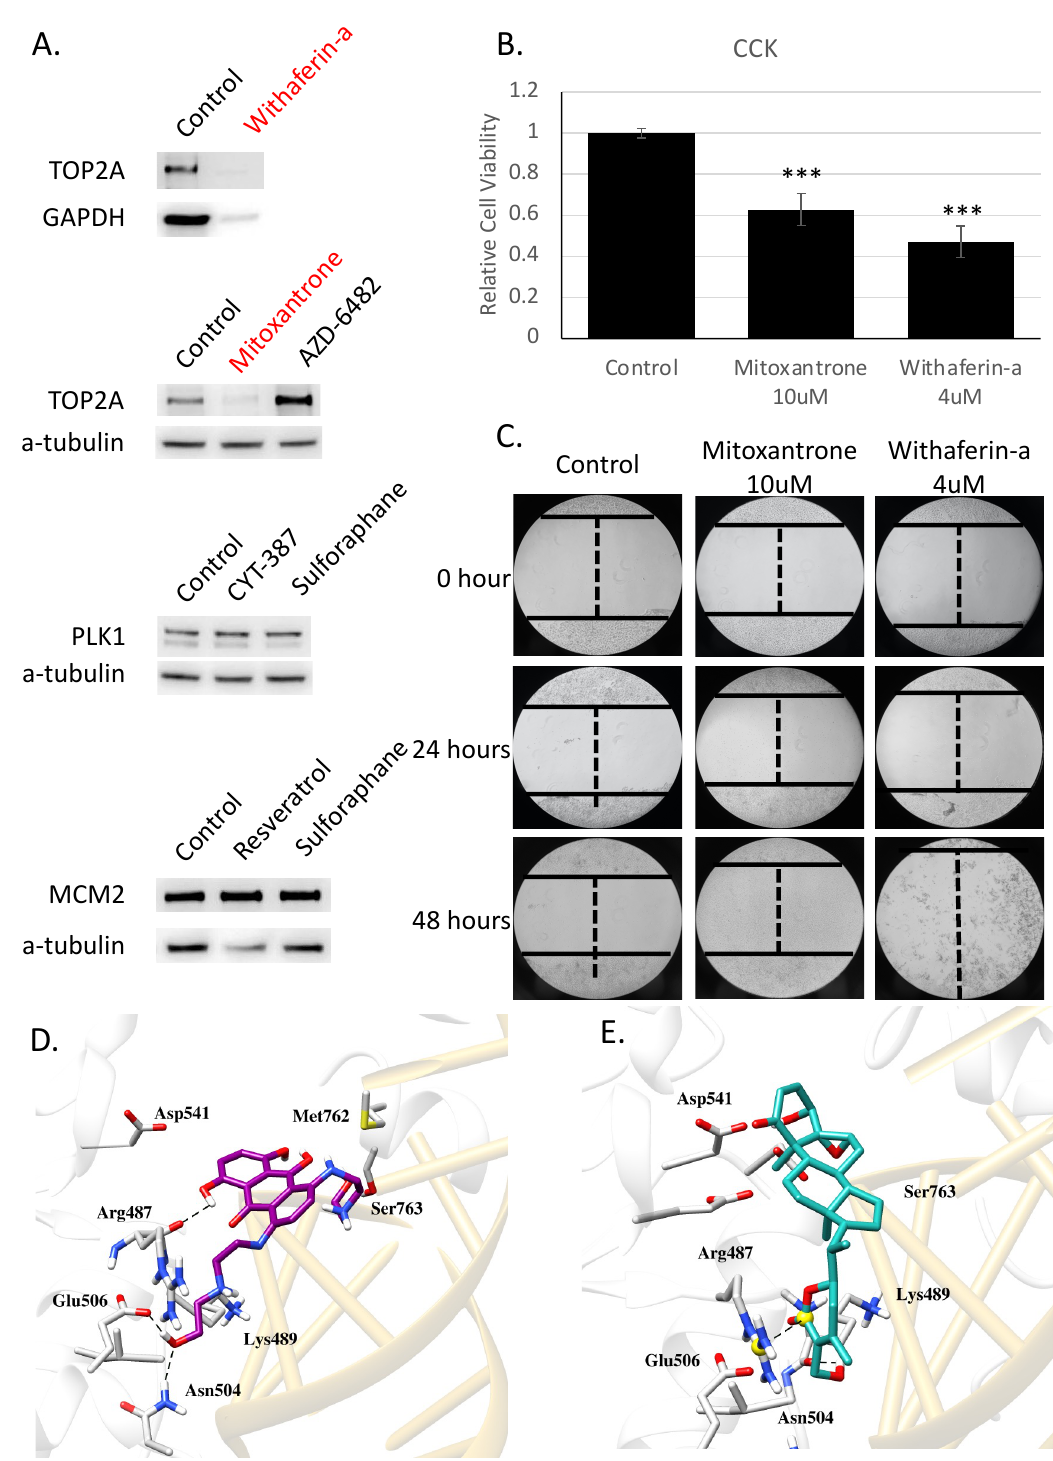
Figure 6. Validation of top effective drugs. ( A ) Protein expression changes with drugs treatment in TOP2A , PLK1 and MCM2 . ( B ) The proliferation assay showed MTX and WFA significantly suppressed TOP2A formation in HepG2 cell line (*** means p < 0.001 in t -test). ( C ) The scratch wound-healing assay showed MTX and WFA strongly inhibit HepG2 cells migration. ( D ) The docked conformation of the MTX inside the binding site of TOP2A . H-bond interactions were represented as black dotted lines. ( E ) The docked conformation of the WFA inside the binding site of TOP2A . H-bond interactions were represented as black dotted